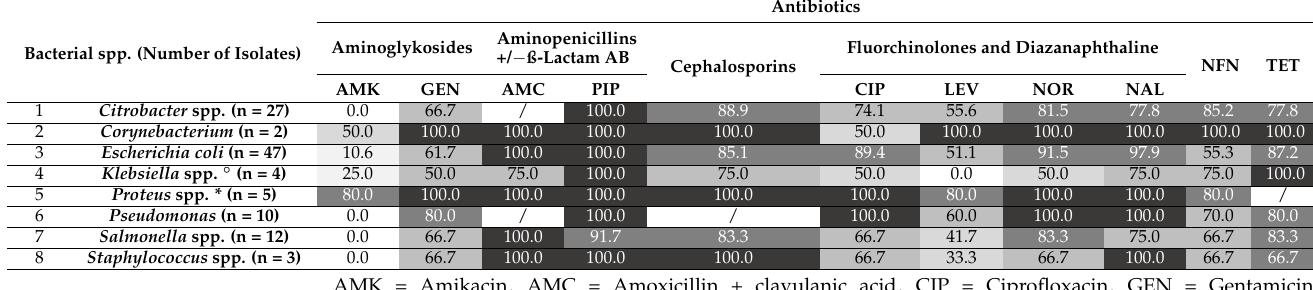
Table 3. Antibiotic susceptibility patterns of uropathogens in percent for all antibiotics tested.